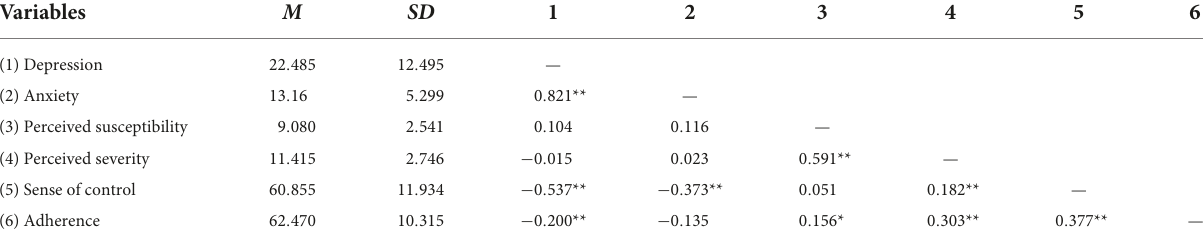
TABLE 2 Correlations between variables. Variables